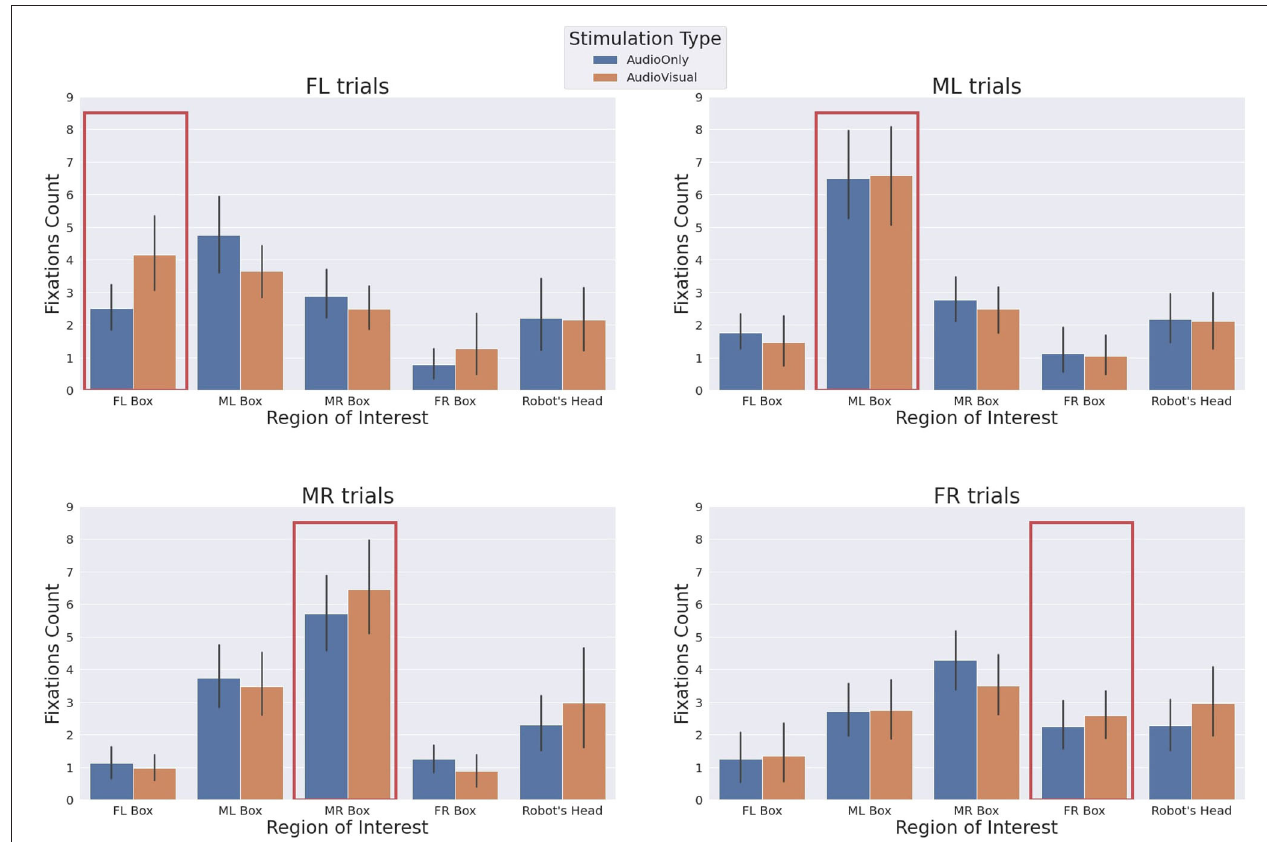
FIGURE 13 | The gaze behaviour of the